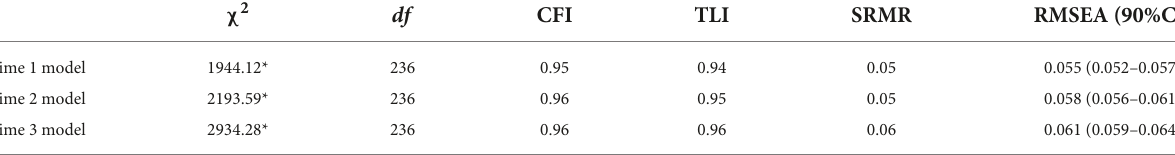
TABLE 3 Cross-sectional CFAs for Time 1, Time 2, and Time 3.